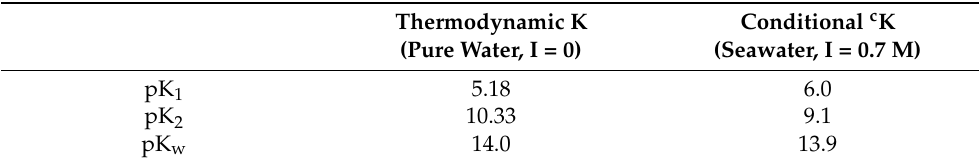
Table 8. Thermodynamic and conditional equilibrium constants for H 2 CO 3 in pure water and seawater (at 25 °C, 1 atm); c K values from [39]. Thermodynamic K